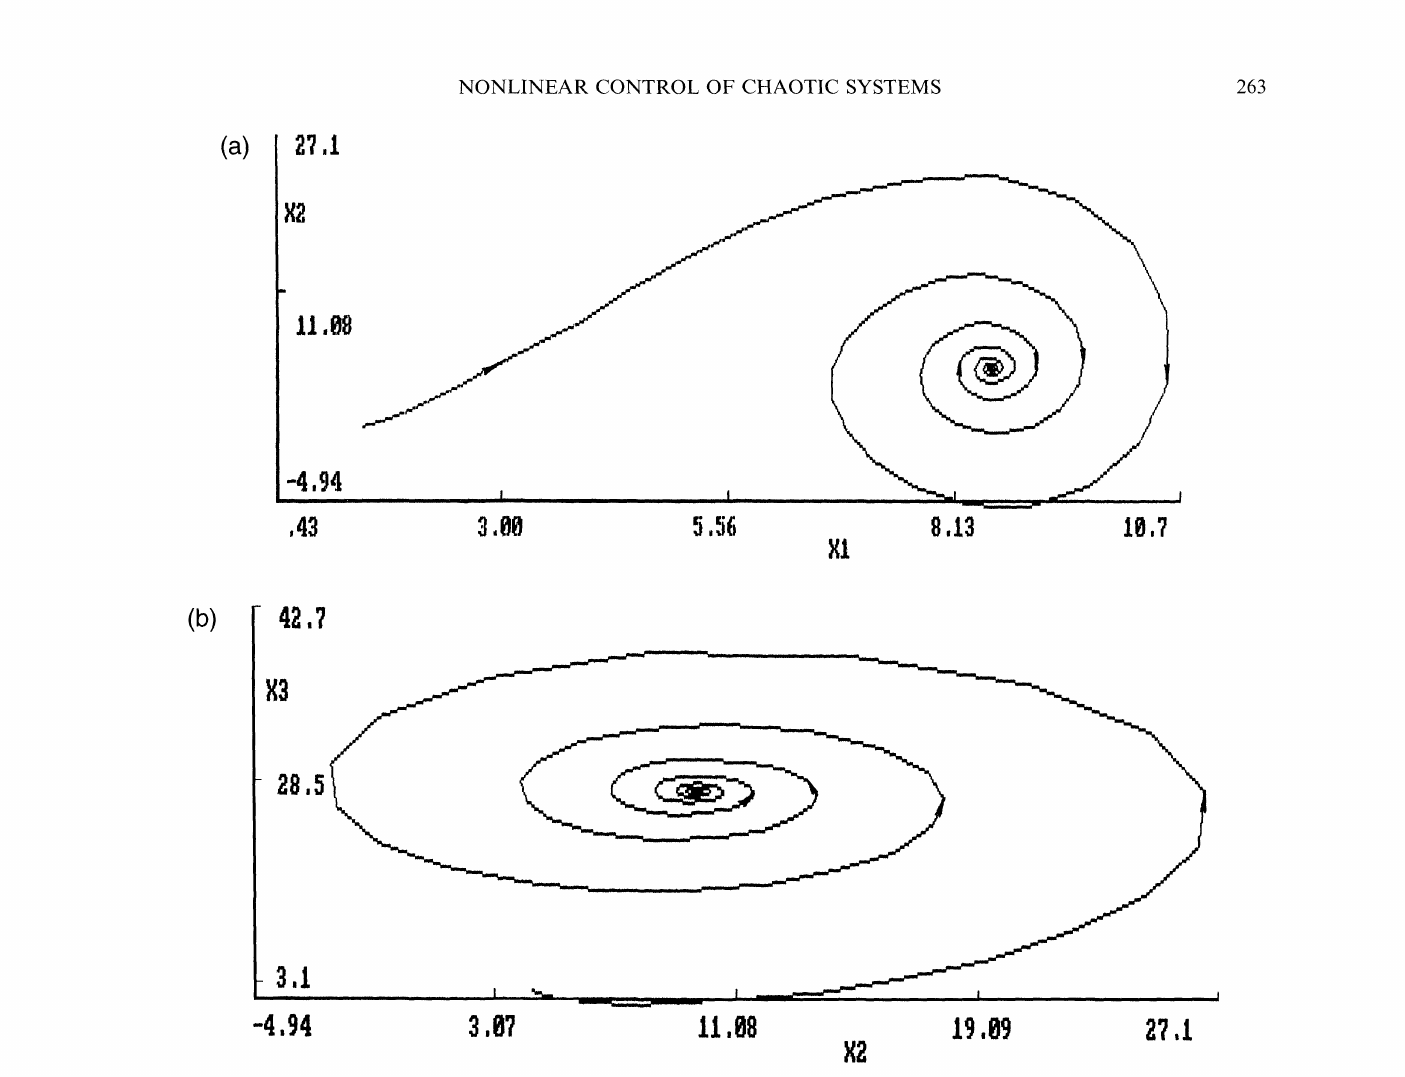
FIGURE 2 The stabilized equilibrium P=(8.48, 8.48,27.00) T of the Lorenz attractor, controlled by (3.3) and (3.5) in the form of (2.3) from beginning, with the same x(0) and as in Fig. 1. (a) Projection in the x2-x plane. (b) Projection in the x3-x2